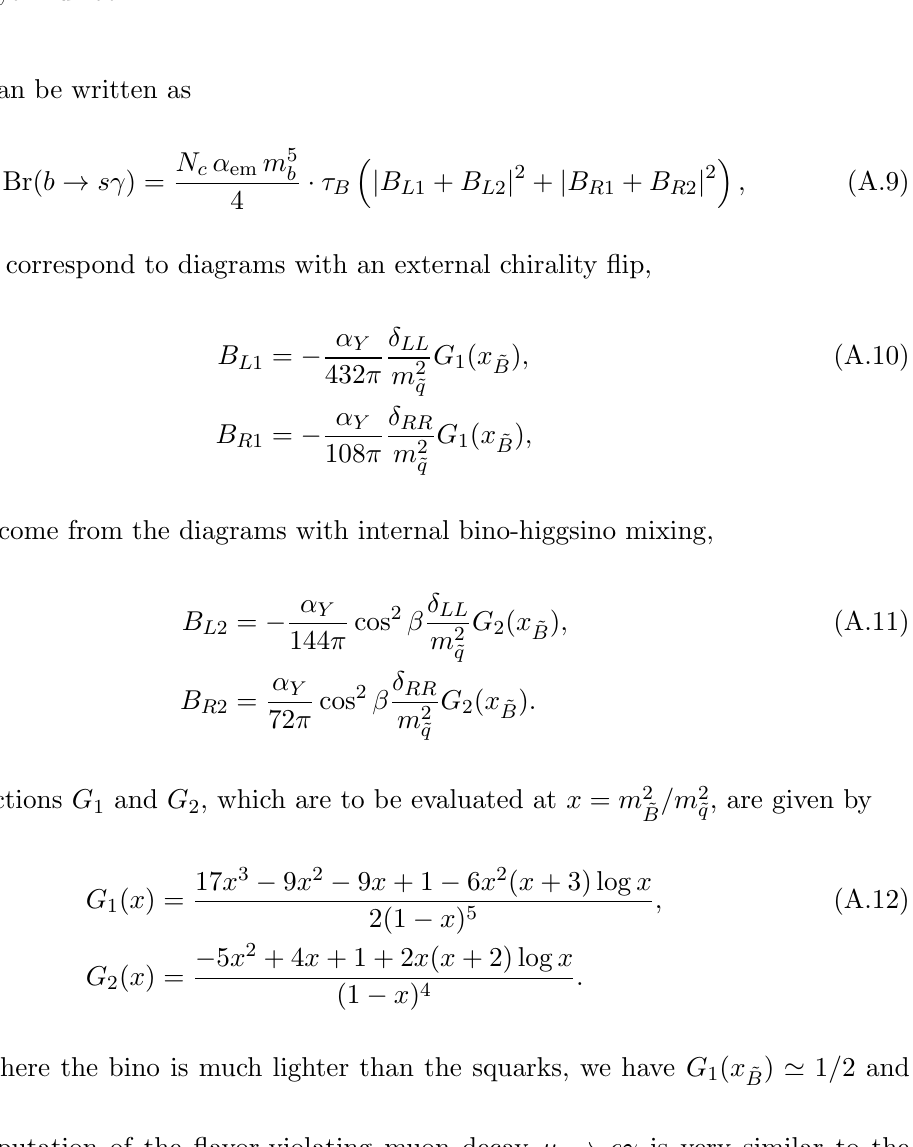
Figure 10. Diagrams for the (cid:13)avor-violating decay b (left) and internal (right) chirality (cid:13)ip. The (cid:13)avor violation arises through o(cid:11)-diagonal terms in the squark mass matrix. The photon can be attached to any charged line. Propagator arrows indicate the (cid:13)ow of baryon